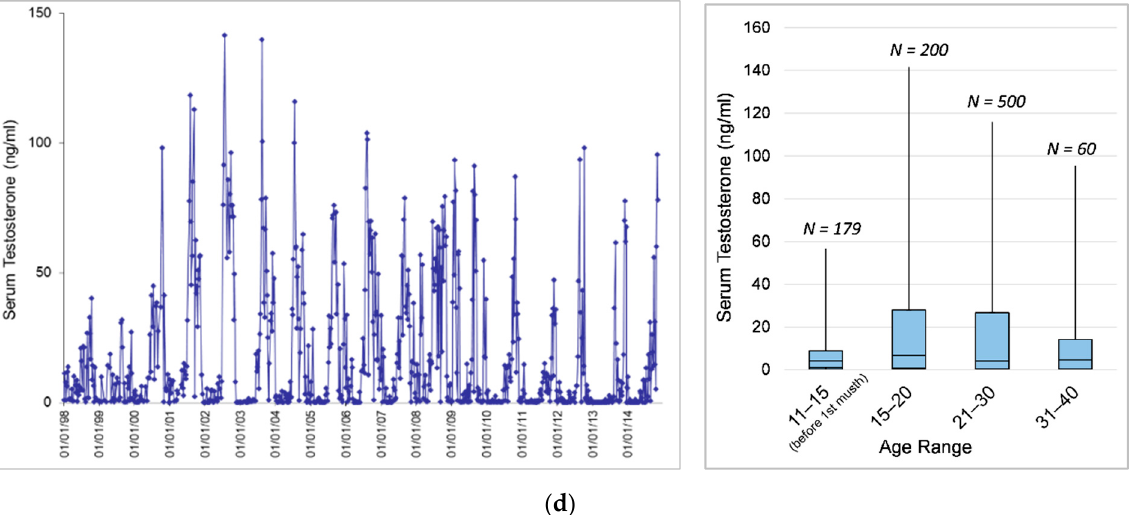
Figure 2. Changes in testosterone concentration in relation to age in individual bull elephants: testosterone profile ( left ), median and variability across age categories ( right ). ( a ) Male1; ( b ) Male2; ( c ) Male3; ( d ) Male4.